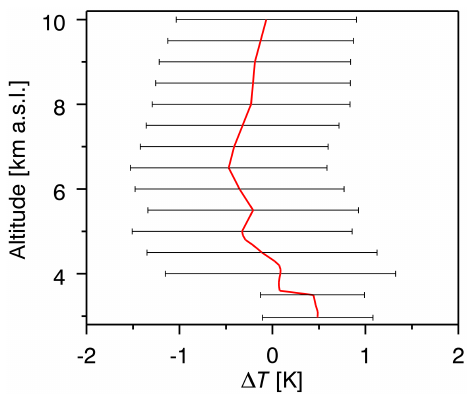
Figure 6. Uncertainty analysis of T profiles used in the closure ex- periment (composite of ER-AERI retrievals < 3km and NCEP). Red is the mean difference between these composite profiles and an ensemble of best-estimate profiles derived from pairs of radioson- des launched with a 1h separation. Black error bars indicate 2 σ of the differences.